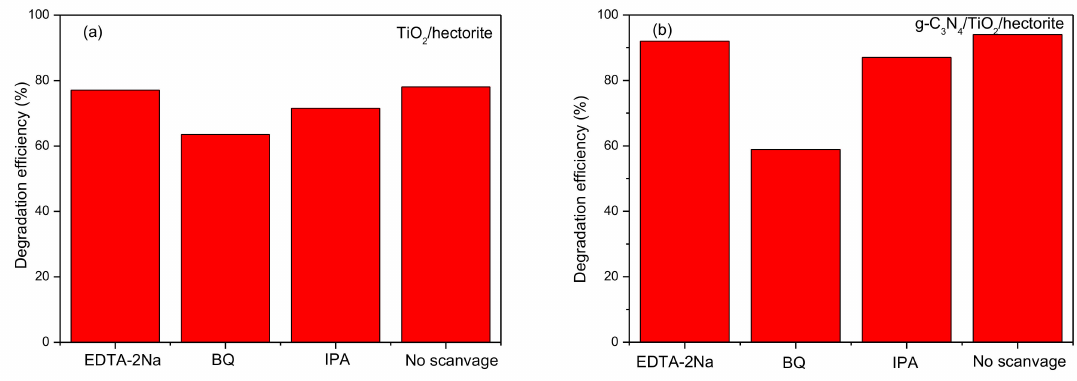
Figure 9. Trapping experiment of active species in the photocatalytic degradation process of RhB over ( a ) TiO 2 / hectorite and ( b ) g-C 3 N 4 / TiO 2 / hectorite